Question: Provide a one-line summary of what is displayed.
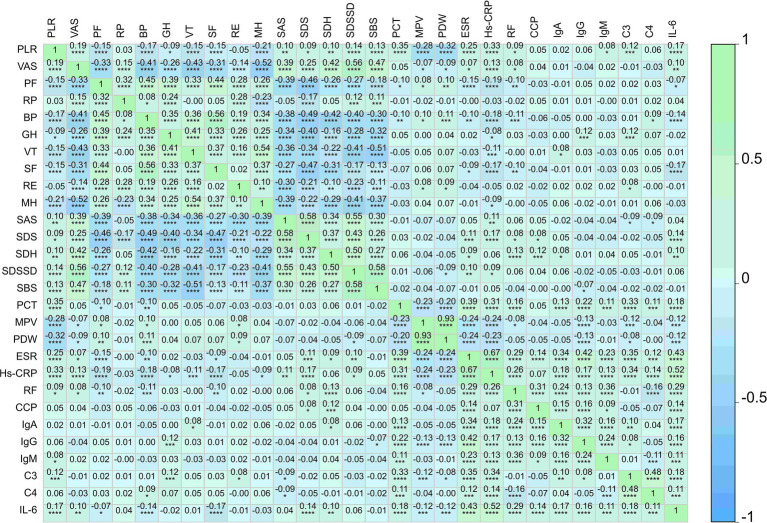
Answer: Heatmap for correlation analysis of PLR, VAS, clinical indicators and SPP indicators.